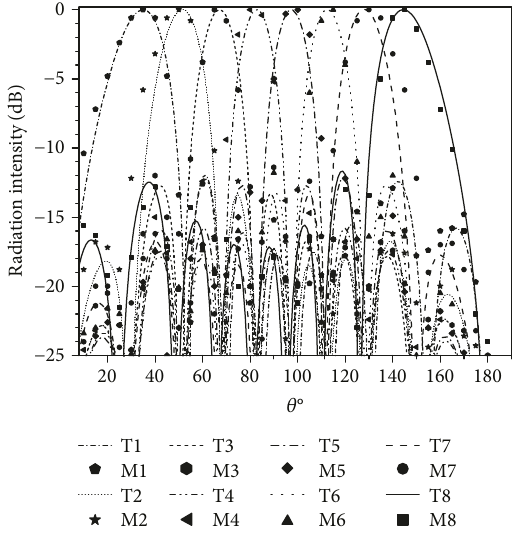
Figure 13: Normalized radiation patterns at 1.9GHz of the 8-element antenna array fed by the 8 × 8 BM. The curves T1-T8 depict the theoretical results that correspond to beams 1-8, respectively, of Table 2. Accordingly, M1-M8 stand for the